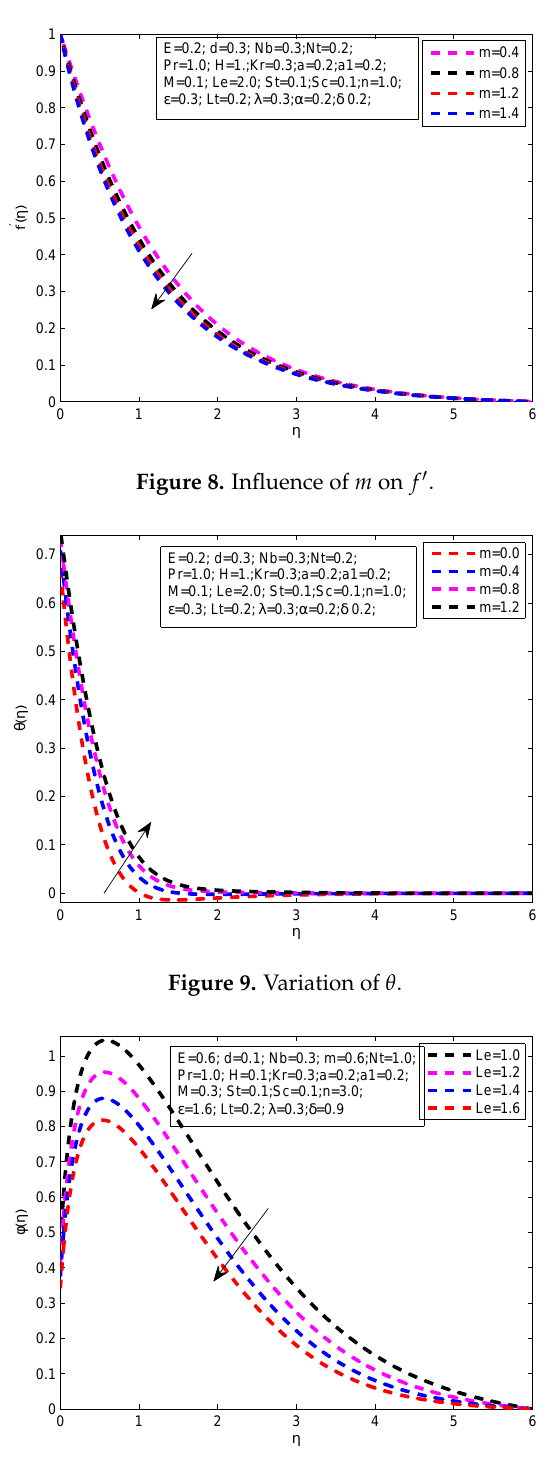
Figure 10. Variation of φ for distinct values of Le